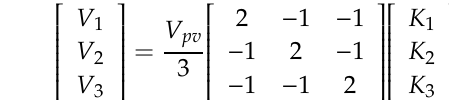
Figure 5. Schematic of ideal Boost converter.